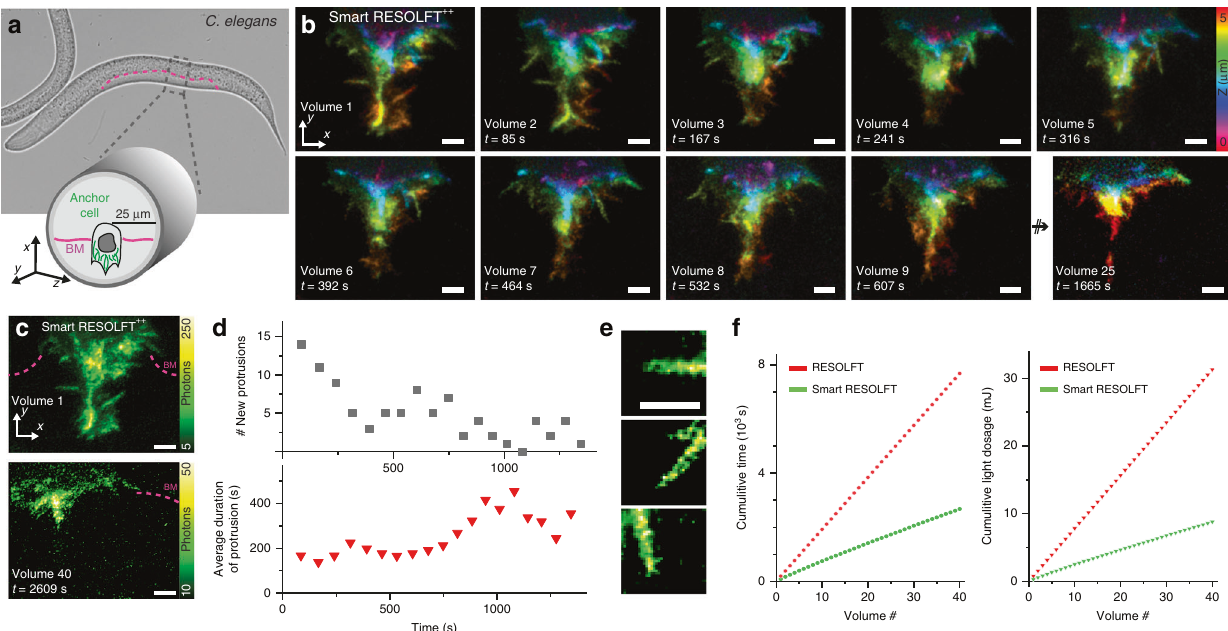
Fig. 6 Smart RESOLFT imaging in vivo. a Conventional transmitted image of C. elegans worm before invasion, with a cartoon showing approximate anchor cell location and anchor cell shape during late invasion. The cell is expressing Lifeact-DronpaM159T which labels actin fi laments (depicted in green) and the basement membrane that is being invaded is depicted in magenta. b We recorded 40 volumes of the anchor cell protrusion post-invasion when it has reached its maximum size and has started retracting. The recording was continuous over 40 min to follow the actin rearrangement post-invasion. Ten representative volumes are shown as color-coded maximum projection of the axial position. Each volume consists of ten smart RESOLFT images. The decision was made with probe type 2. c Maximum intensity projections of fi rst and last (40th) recorded volumes to highlight the retraction stage of invasion. By the time of the last recorded volume, the anchor cell protrusion was mostly retracted as per usual for this stage of morphogenesis. d Plots displaying the number of actin spikes and their lifetimes during protrusion retraction post-invasion. At the beginning of the process, newly formed actin spikes are more numerous (top) but dynamic and short-lived (bottom), while at end of the acquisition when the protrusion is retracting, new spikes are rare, but existing spikes are more stable (longer lifetimes). e The images show three representative protrusions with fi ne actin bundles. They are examples of the protrusions detected and measured in the graphs. f The two graphs show the reduced exposure time (left) and light doses (right) of the smart RESOLFT (green) compared to conventional RESOLFT (red) recording. Scale bars are 1 µ